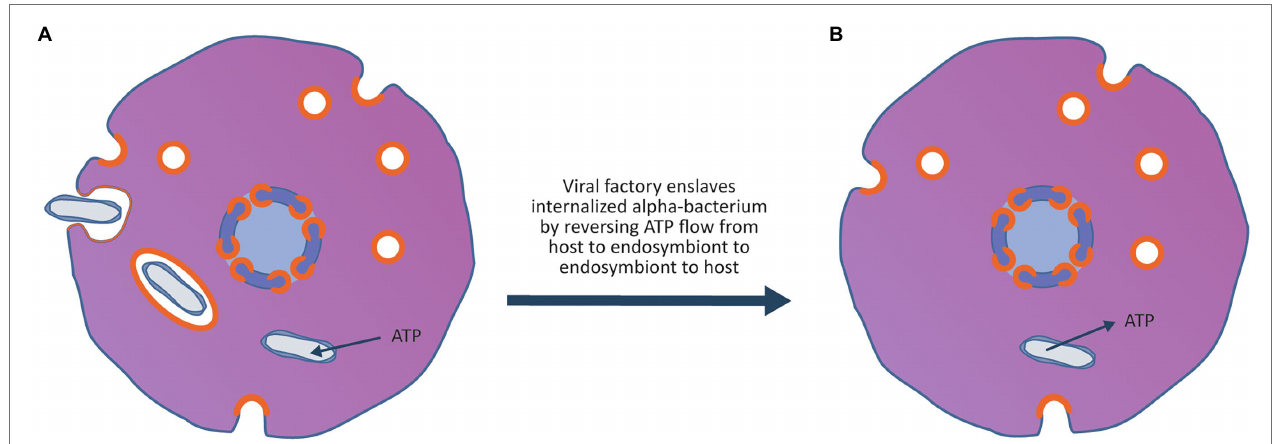
FIGURE 4 | Enslavement of a parasitic alpha-proteobacterium by the virocell leads to the evolution of an emergent superorganism. (A) An alpha-proteobacteria evolves the ability to enter the cell exploiting the vesicle system of the archaeal virocell. Once inside the cell, the bacterium can escape the vesicle and enter the host cytoplasm. After entry to the cytoplasm, the bacterium imports ATP and nutrients from the host cytoplasm and becomes an internal energy parasite of the virocell. These internal bacterial parasites are ancestors of the Rickettsia -like eukaryotic parasites as well as the mitochondria. (B) The rare event that made the process of eukaryogenesis unique in the history of life on earth occurred when the viral factory evolved the ability to enslave the mitochondrion, forcing it to stop importing ATP and nutrients from the host cytoplasm and instead export ATP and nutrients into the host cytoplasm. By taking control of the metabolism of the bacteria, the bacterium was changed from an energy parasite into the endosymbiotic powerhouse of the superorganism. The advantage to the viral factory of enslaving the bacterium ensured that the virocell and the enslaved bacterium embarked on an evolutionary trajectory of increasing metabolic and genetic integration, leading to the evolution of an emergent